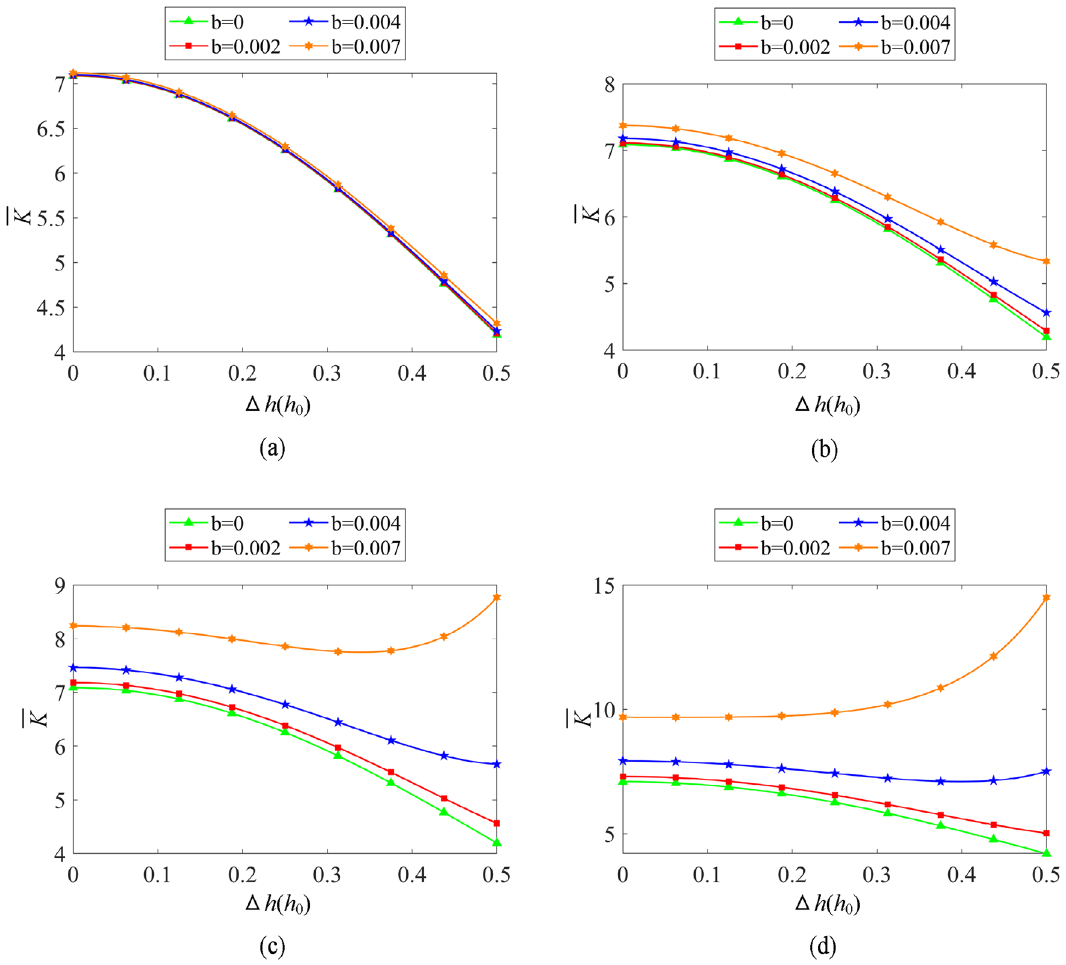
Figure 12. Influence of boundary slip on oil film stiffness ( ω 2 = 0 rpm) ( a ) ω 1 = 1000 rpm, ( b ) ω 1 = 3000 rpm, ( c ) ω 1 = 6000 rpm, ( d ) ω 1 = 9000